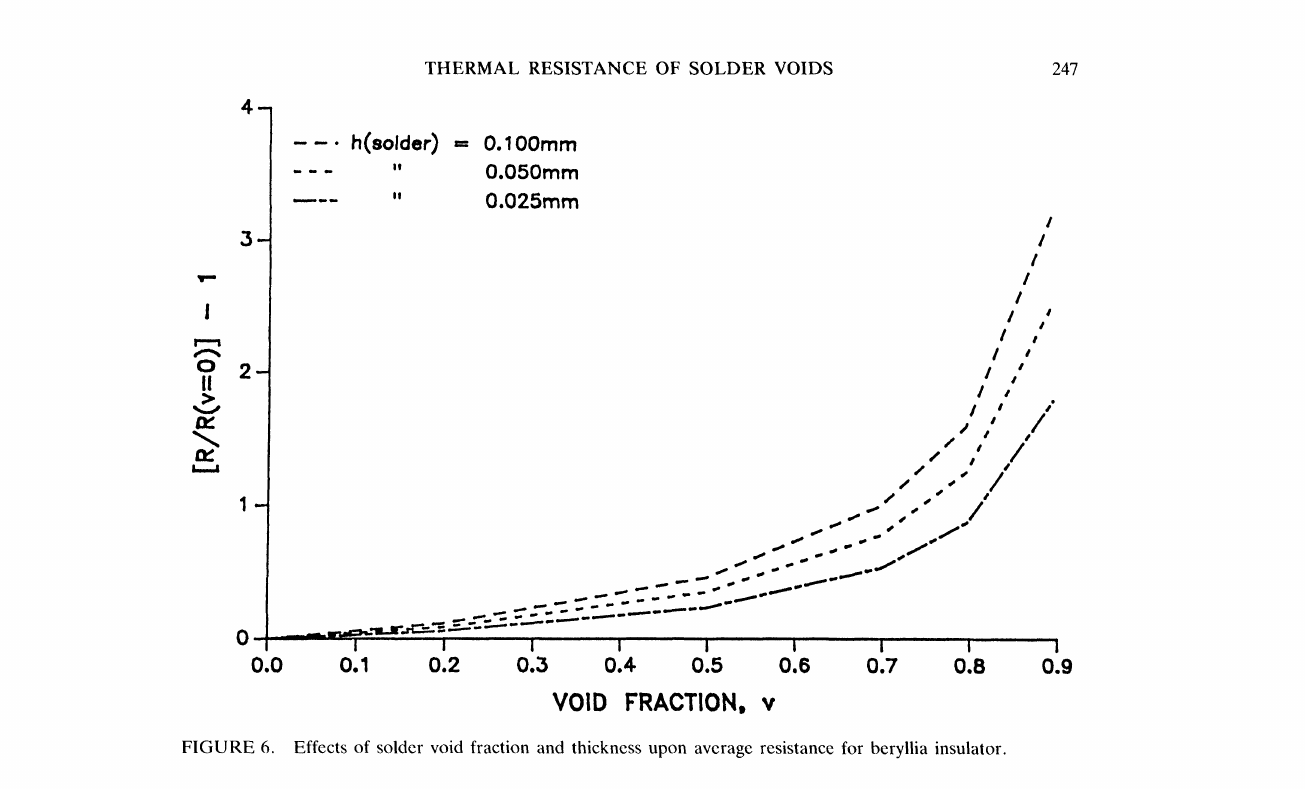
FIGURE 6. Effects of solder void fraction and thickness upon avcragc resistance for beryllia